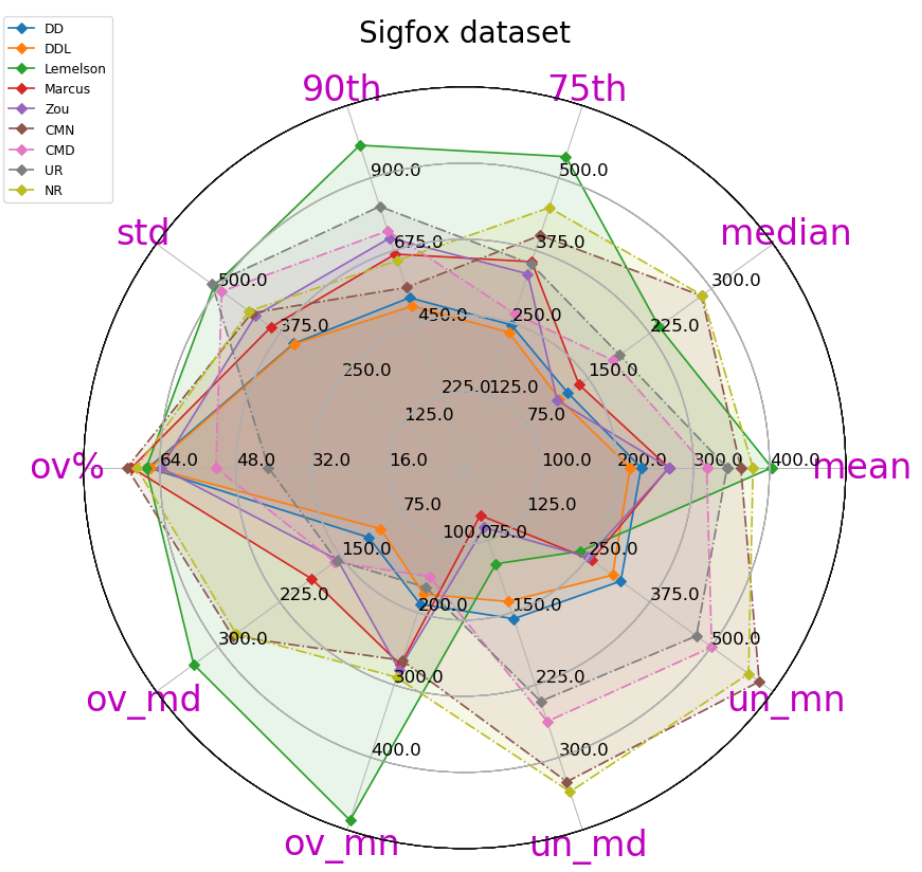
Figure 2. A radar plot of most of the relevant metrics for the DAE evaluation of various methods, on the validation set of the Sigfox dataset. Methods are depicted in continuous lines while baselines are in dashed lines. This plot depicts metrics and values of all methods, as reported in Table